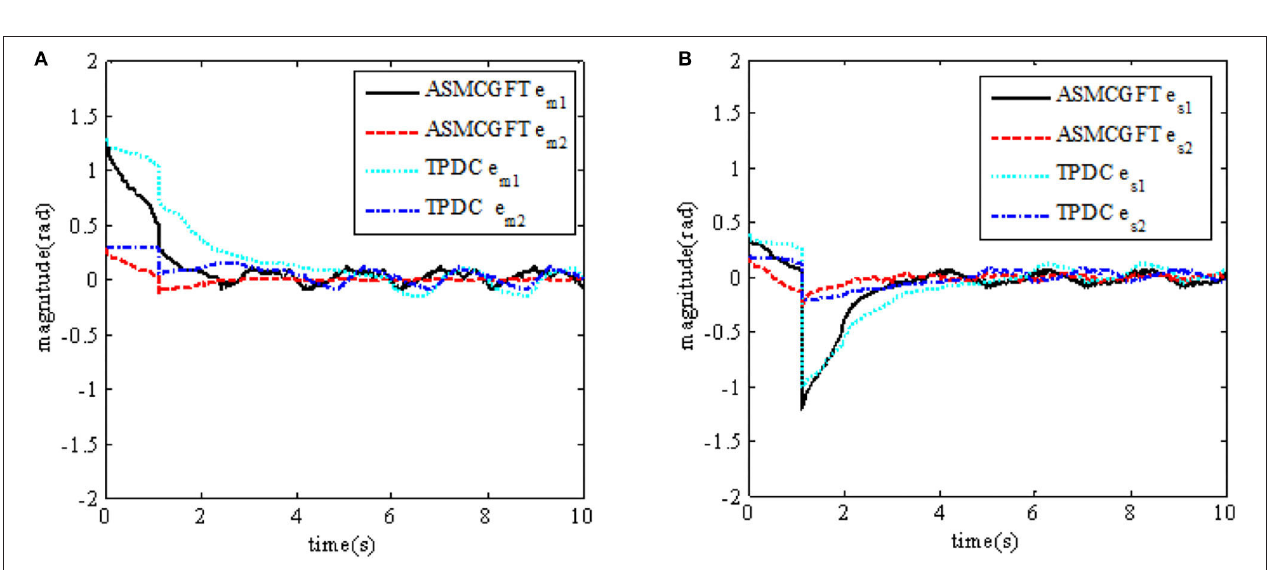
T . Set the initial position of the master robot from the interaction between the robot and the environment is T . = 0 0 selected as f ∗ and the slave robot. The time delay of forward and reverse e In the process of building a closed-loop teleoperation communication channels of teleoperation system is T m = (cid:2) (cid:3) system, the mechanical constant parameters related T s = 0.6 s . to the dynamics of the master robot, the slave robot, In the simulation teleoperation system, the master robot the operator, and the environment are shown in and the slave robot controller adopt Formula (9) and Formula Table 1 . (10). After repeated debugging, the controller parameters in the In the simulation, it is assumed that the uncertain part of remote operation system are K m = K s = diag ( 3, 3 ) , B m = B s = the master robot’s dynamic model is 1 M m = 0.3 sin (2 t ) M om , diag ( 3, 3 ) , α m = α s = diag (1, 1), β m = β s = diag (1, 1), ε m = 1 C m = 0.2 sin (3 t ) C om , 1 G m = 0.1 sin (4 t ) G om and that of the ε s = diag (3, 3), γ m = γ s = diag (1.5, 1.5), ρ m = ρ s = diag (1 / 3, 1 / 3). The adaptive law is equation. After slave robot’s dynamic model is q m ( 0 ) = (cid:2)